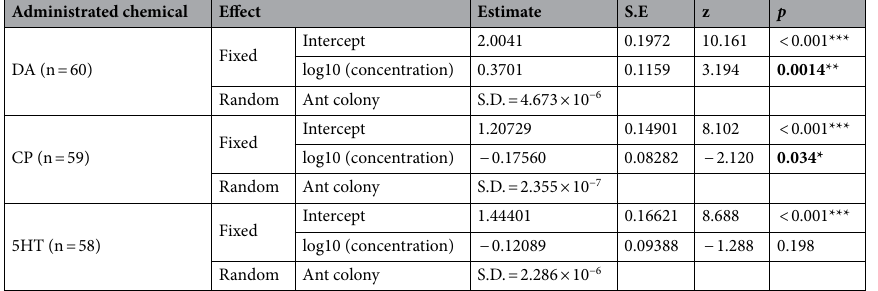
Table 1. The results of generalized linear mixed model analysis by setting aphid colony as a random effect for 3 experimental chemicals. We consider that the significance of the intercept is not as important as the slope, so only significant p -value( p < 0.05) of the slope was bolded. Dopamine (DA) showed a significant positive effect (estimate = 0.370, n = 60, z = 3.194, p = 0.0014) on the aggressiveness of L. japonicus workers as with its concentrations. An antagonist of DA (chlorpromazine: CP) significantly suppressed the effect of an enough DA concentration (10 mM) (estimate = − 0.176, n = 59, z = − 2.120, p = 0.034). Serotonin (5HT: the second- most concentrated amine in the honeydew in attending ant crops) had no effect (estimate = − 0.121, n = 58, z = − 1.288, p = 0.198). Both TA and OA had no significant effect on the aggressiveness of ants (the results for TA and OA are shown in the text). *** p < 0.001, ** p < 0.01, * p <